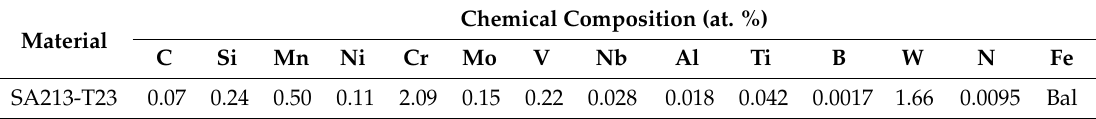
Table 1. Chemical composition of the T23